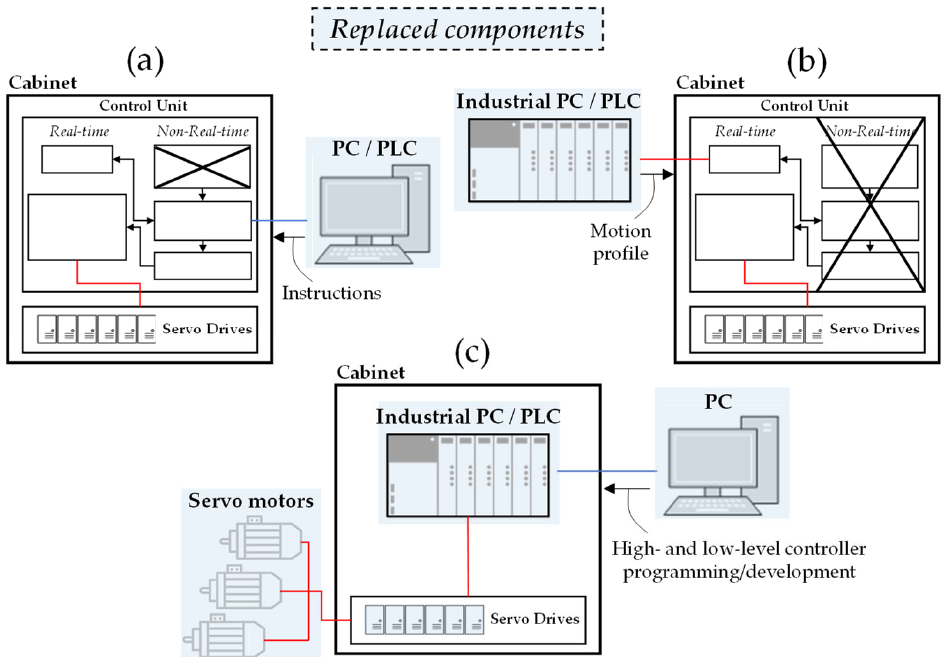
Figure 2. Schematic of the innovative IR control approaches. ( a ) External coordinator, ( b ) External trajectory generator, and ( c ) Open controller.